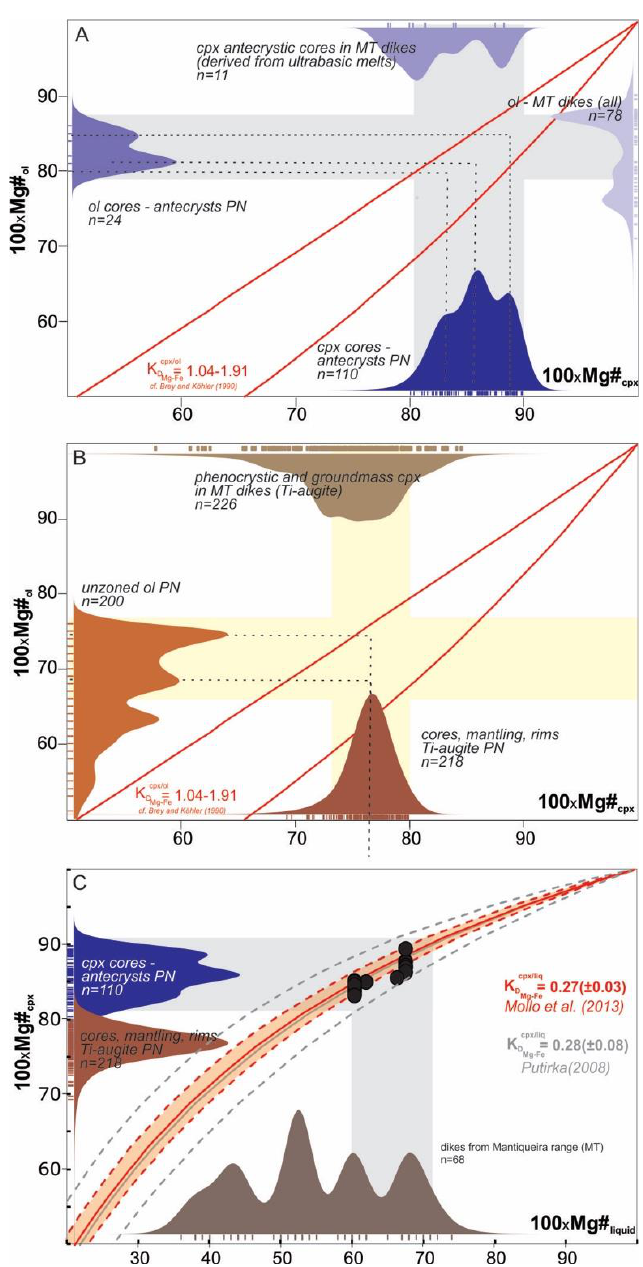
Figure 8. Mg – Fe equilibrium exchange between clinopyroxene and olivine from PN and liquids from Mantiqueira Range (compiled data from [37]). ( A , B ) KDEs of Mg# cpx vs. KDEs of Mg# ol are compared with the curves of Mg – Fe exchange calculated using experimentally determined coefficients ( 𝐾 𝐷𝐹𝑒−𝑀𝑔𝐶𝑝𝑥−𝐿𝑖𝑞 ) ranging from 1.04 – 1.91 ([63]), and believed to represent crystallization in equilibrium conditions. ( C ) Mineral-melt equilibrium diagram with KDE of the Mg# cpx of the PN with the KDE of Mg# of alkaline dikes from the Mantiqueira Range [38], attributed to potential liquids from which cumulates were formed [Mg# liquid = Mg/(Mg+Fe 2+ ), molecular proportions and using Fe 2+ /∑Fe = 0.85]. The curves represent the range in which mineral and melt compositions are in equilibrium based on iron – magnesium exchange [65]. Iron-magnesium coefficients are from compilation of [66] and [67] for clinopyroxene – liquid exchanges. Based on (C), the high-Mg diopside relict cores are in equilibrium with the high-Mg liquids (Mg# > 60) of the Mantiqueira Range, whereas the most common Ti-augite and unzoned olivines are mostly in equilibrium with dike compositions with 45 < Mg# < 50. The points plotted in graph are the pairs of clinopyroxene – liquid which attended to the filters of equilibrium conditions for the application of the geothermobarometer of [68].